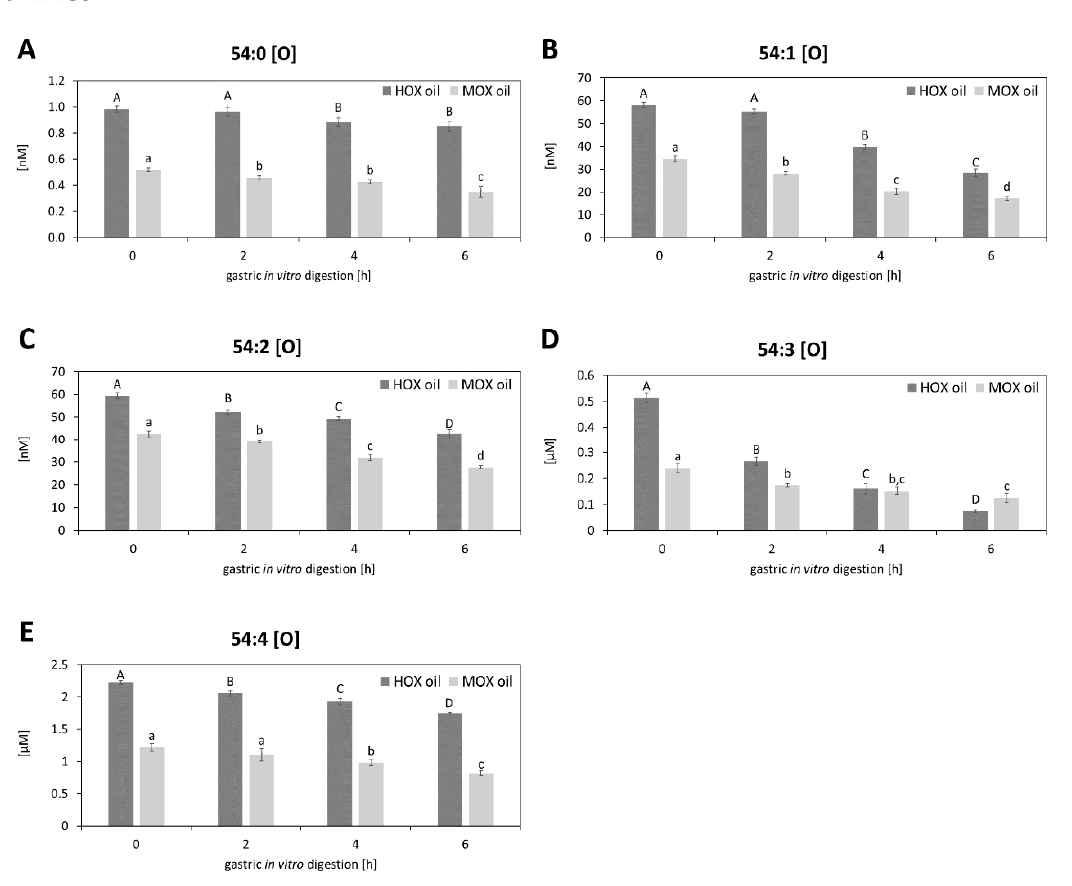
Figure 3. E ff ects of the gastric in vitro digestion on the epoxidized triacylglycerols (O) in the moderately and the highly oxidized grape seed oils: ( A ) 54:0 (O), ( B ) 54:1 (O), ( C ) 54:2 (O), ( D ) 54:3 (O) and ( E ) 54:4 (O). Statistically significant di ff erences between the time of digestion (0, 2, 4, 6 h) for each oil are indicated by di ff erent letters ( n = 3, One-Way-ANOVA, Holm–Sidak, p < 0.05). Capital letters indicate significant di ff erences between the time of digestion of the H OX oil, lowercase letters mark significant di ff erences between the time of digestion of the M OX oil.